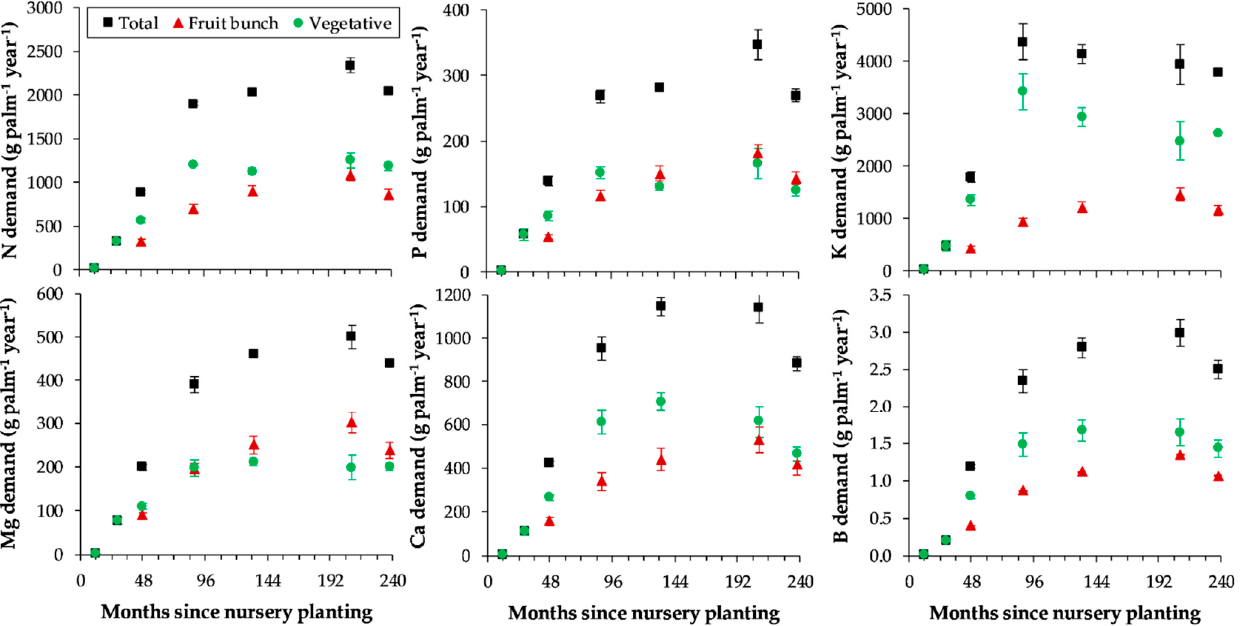
Figure 3. Mean amounts of N, P, K, Mg, Ca, and B required to meet nutrient demand for vegetative growth and fruit-bunch production of tenera oil palm of different ages sampled in this study. Error bars are standard errors.